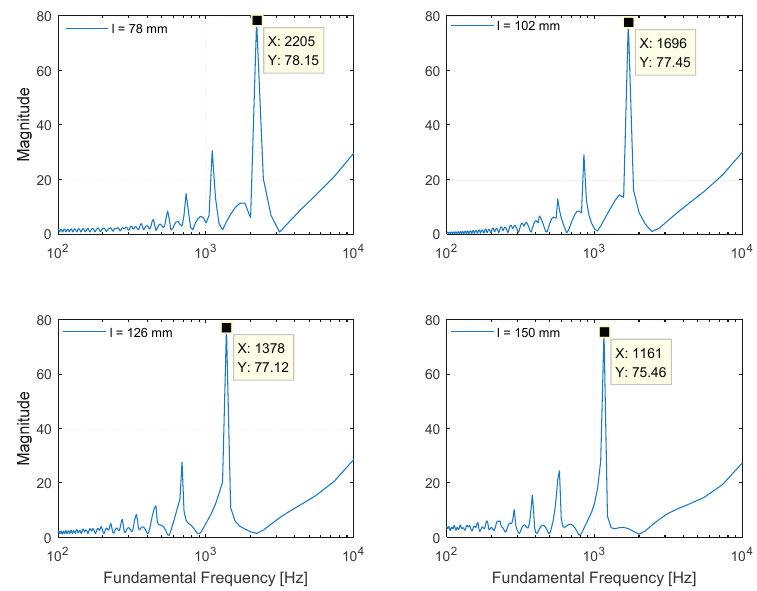
Figure 9. Plot matrix for simulated fundamental frequency of cylindrical pipe ( d = 10 mm, h = 3 mm, and w = 8 mm) with selected